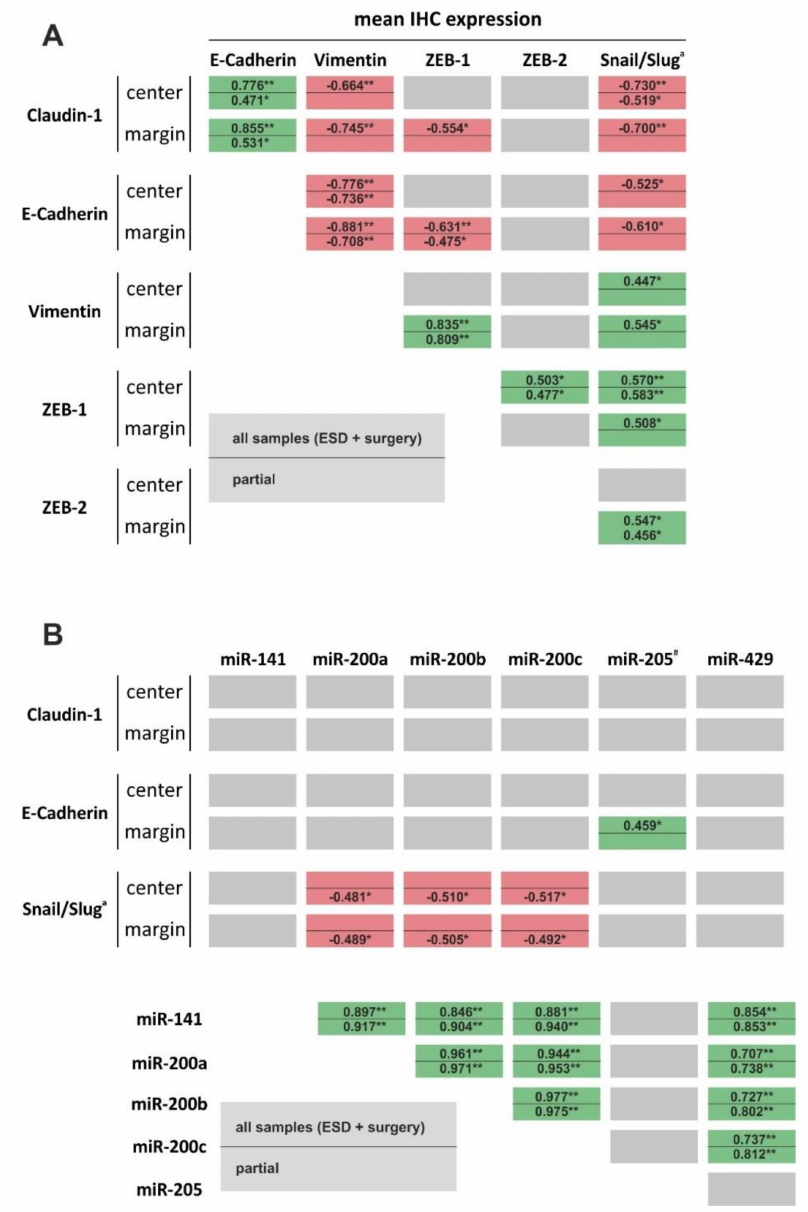
Figure 5. Correlation analysis between EMT markers ( A ) and EMT markers and EMT-related miRs ( B ). Green and red highlighted boxes represent positive and negative significance, respectively. Grey boxes illustrate no significant correlation. Within each box, values above the line represent correlation analysis of all samples (ESD and surgically resected samples), whereas values below the line are results of partial correlation analysis (all ESD samples versus all surgically resected samples). * indicates significance ( p < 0.05), ** indicates high significance ( p < 0.01). Abbreviations: EMT = epithelial-to-mesenchymal transition, ESD = endoscopicsubmucosaldissection, miR = microRNA.#miRwithsignificantexpression di ff erences between ESD and surgically resected samples. a nuclear